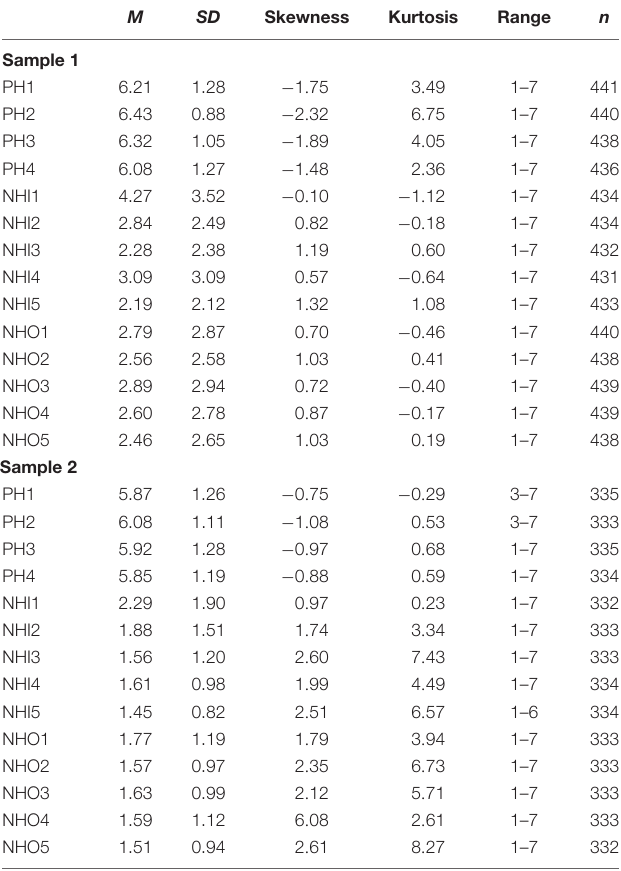
TABLE 2 | Descriptive Statistics of the Items of the HCSS (Top Part-sample 1, Bottom Part-sample